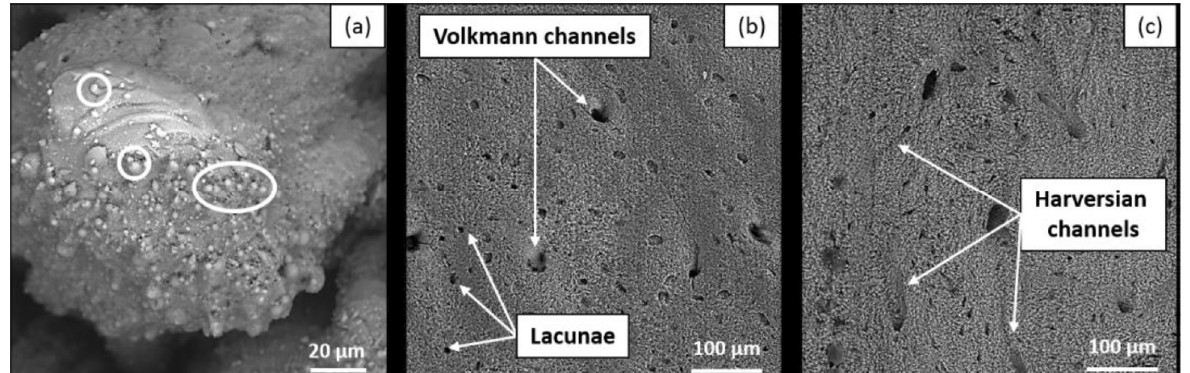
Figure 1. Bone tissues after ultrafast laser ablation under SEM imaging in the visible regime showing ( a ) laser-induced thermal damages (spherical structures indicated by the white circle) at a higher PRR (515 nm, 1000 kHz, 4000 mm/s, 6.27 W), while ( b ) shows native bone structures such as Volkmann channels and lacunae at a lower PRR (515 nm, 250 kHz, 4000 mm/s, 6.27 W), as well as the Harversian channels shown in ( c ) after ablation in the IR regime (1030 nm, 250 kHz, 1000 mm/s, 6.27 W). Adapted from [44].